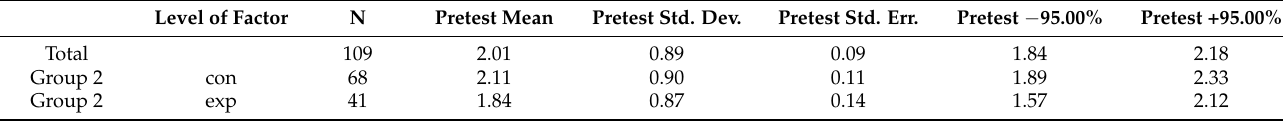
Table 3. Descriptive statistics for the